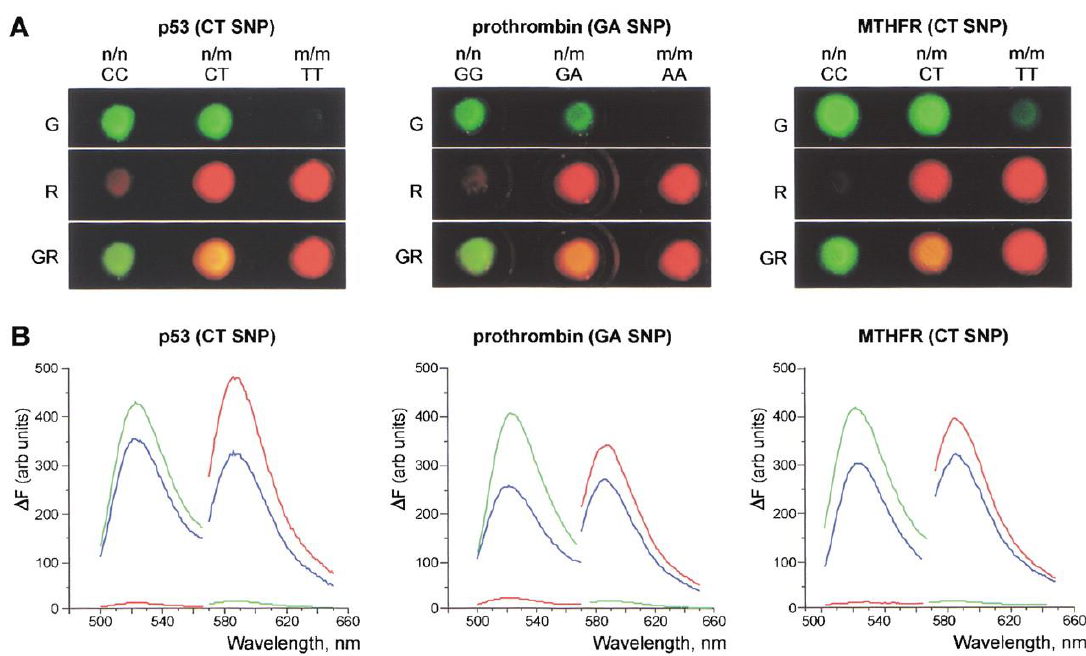
Figure 7. Investigation of p53 C309T , prothrombin 20210 G-to-A , and MTHFR C677T polymorphous sites in homozygous and heterozygous DNA via the DSNP assay. ( A ) Images obtained with the fluorescent stereomicroscope equipped with green (G) and red (R) filters. GR: computer superposition of images obtained with green and red filters; n/n: homozygous DNA samples comprising wild-type sequence variant; n/m: heterozygous DNA samples; m/m: homozygous DNA samples comprising mutant sequence variant. ( B ) Normalized emission spectra of these samples obtained by the spectrofluorometer, with excitation wavelengths at 480/550 nm for green/red fluorescence, respectively. Green line: homozygous DNA samples comprising the wild-type sequence variant; red line: homozygous DNA samples comprising the mutant sequence; blue line: heterozygous DNA samples. Reprinted with permission from Ref. [100].